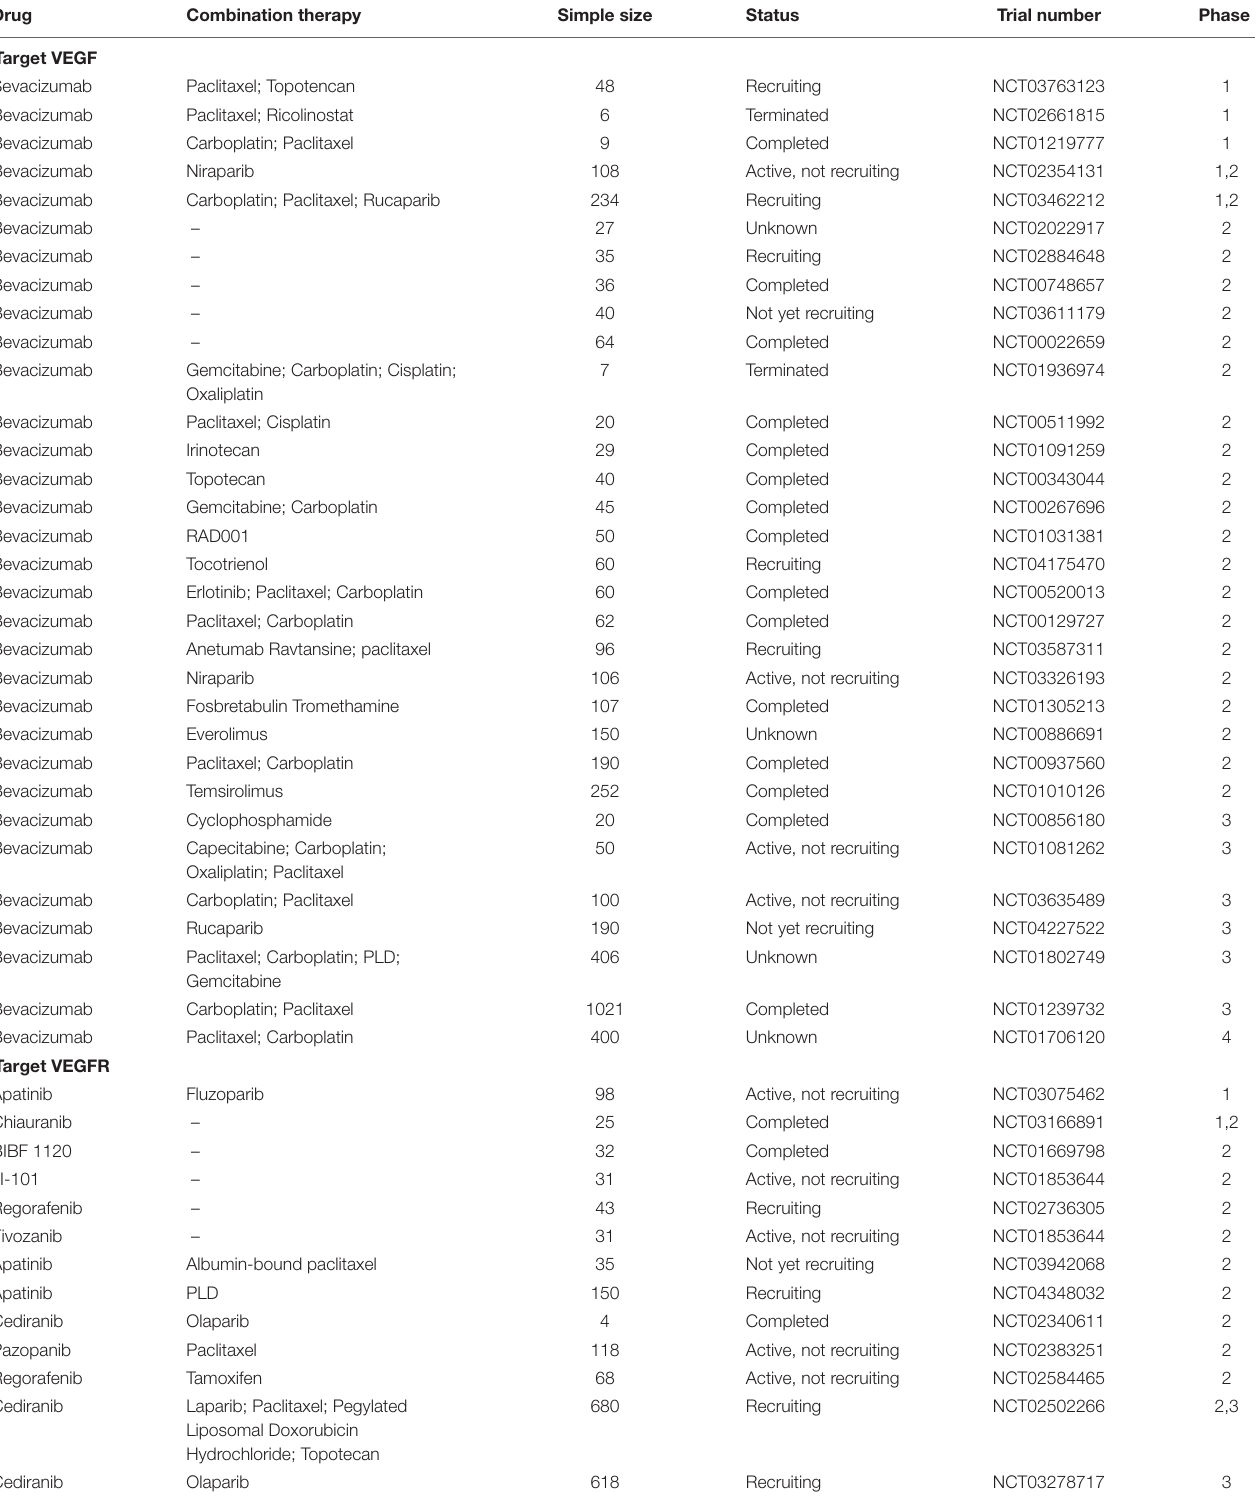
TABLE 3 | Ongoing clinical trials targeting ovarian cancer tumor microenvironment